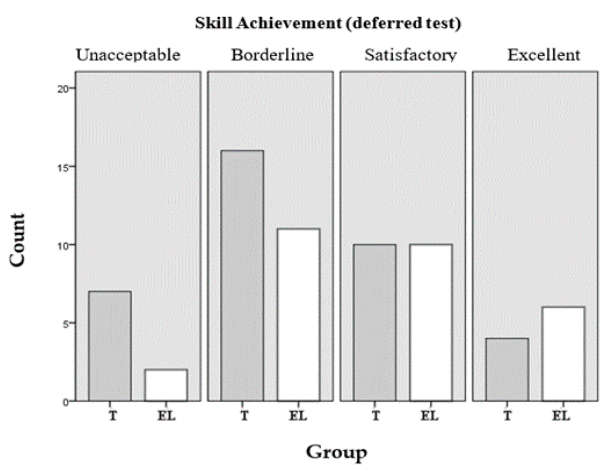
Figure 6. Achievement levels in technical skills (deferred test). Table 10. Linear association measures: agreement between reviewers and technical